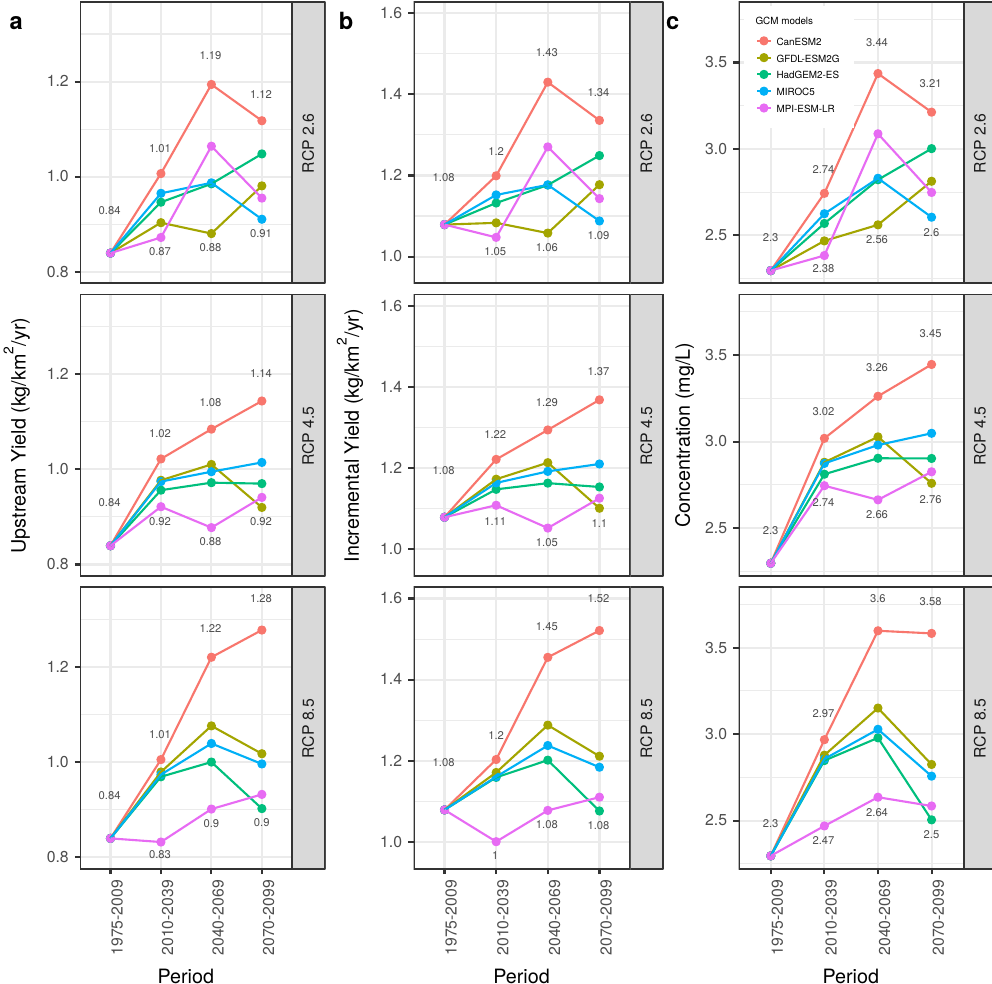
Figure 3. Projections of spatio-temporal annual averages of ( a ) upstream yield (kg km − 2 year − 1 ); ( b ) incremental yield (kg km − 2 year − 1 ) and ( c ) concentration (mg L − 1 ) for TN. Minimum